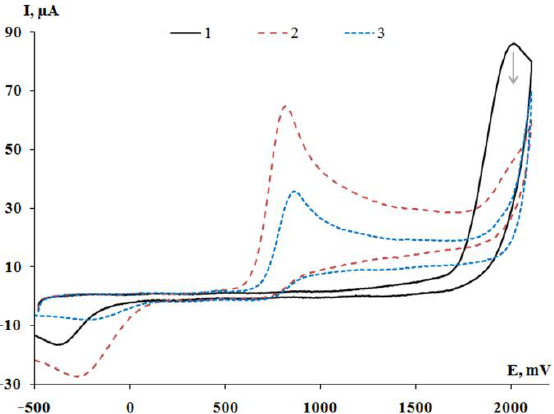
Figure 13. The CV of free PySSPy (curve 1); The CV of reaction mixture of (3,6-DBCat)SbPh 3 and PySSPy in a ratio 1:1 (curve 2); The CV of a reaction mixture of (3,6-DBCat)SbPh 3 ) and PySSPy in a ratio 2:1 (curve 3). The potential sweep from − 0.5 to 2.1 V, CH 2 Cl 2 , GC, C = 3 × 10 − 3 M, 0.1 M Bu 4 NClO 4 , vs. Ag/AgCl/KCl(sat.)).